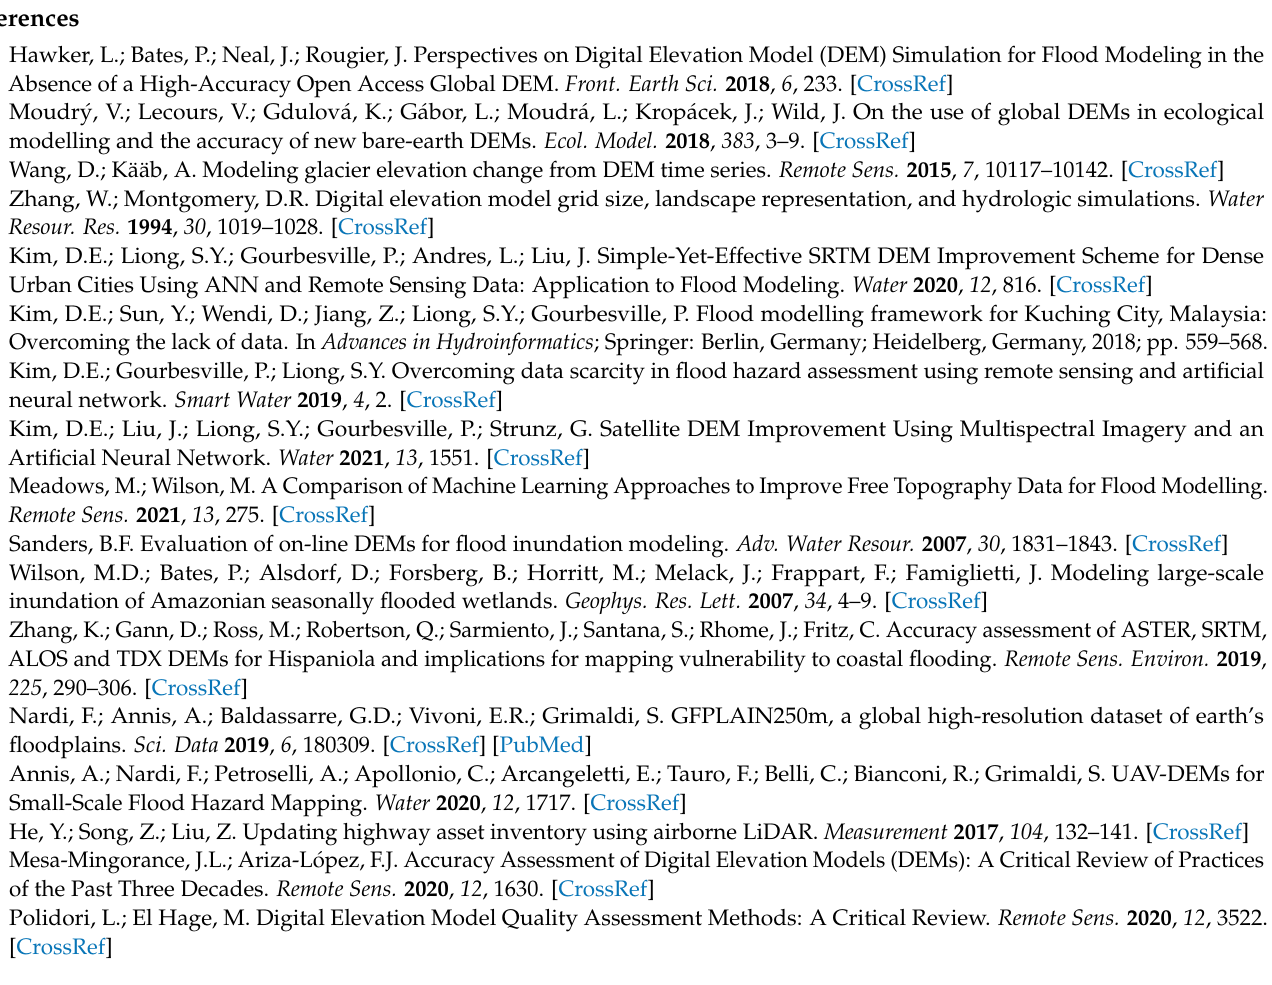
Figure A2. Plots at the testing site in the Orchard Road area (Singapore) of: ( a ) satellite image, ( b ) SRTM DEM, ( c ) reference DEM and ( d ) iConvDEM-2.